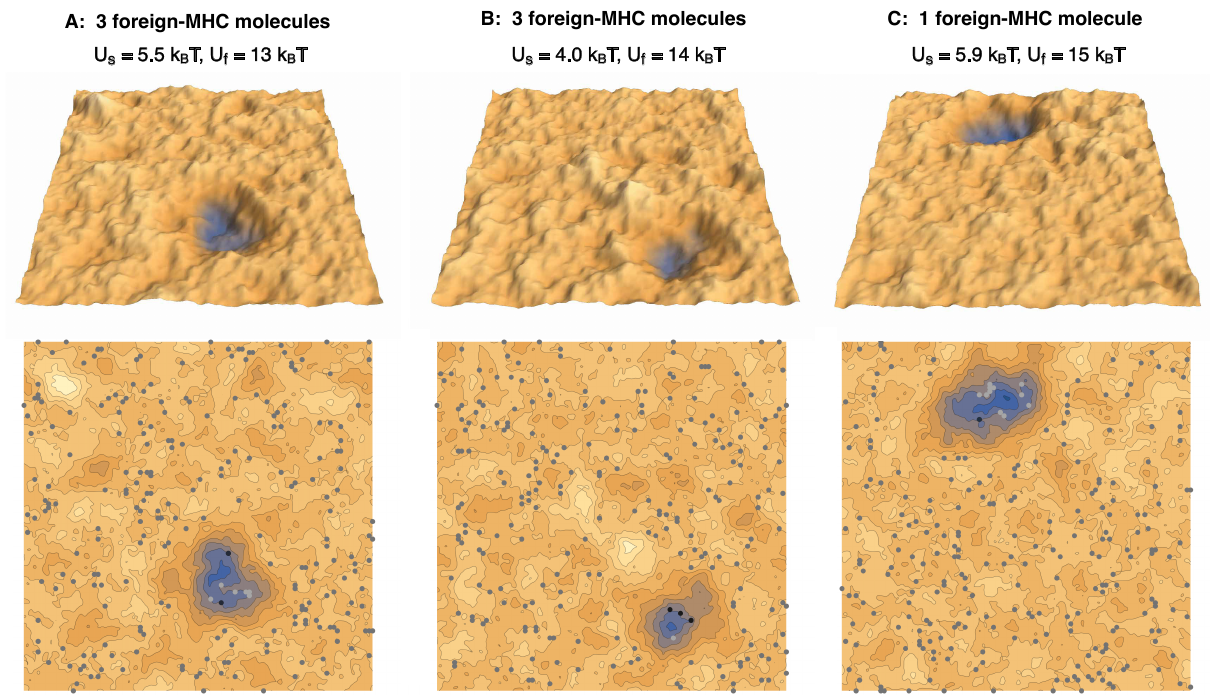
Figure 5. Simulation conformations of membrane segments with area 1.5 × 1.5 µ m 2 in adhesion scenarios with ( A , B ) three foreign-peptide-MHCs and ( C ) a single foreign-peptide-MHC. The different complexes and different values of the membrane separation are indicated in the same colors as in Figure